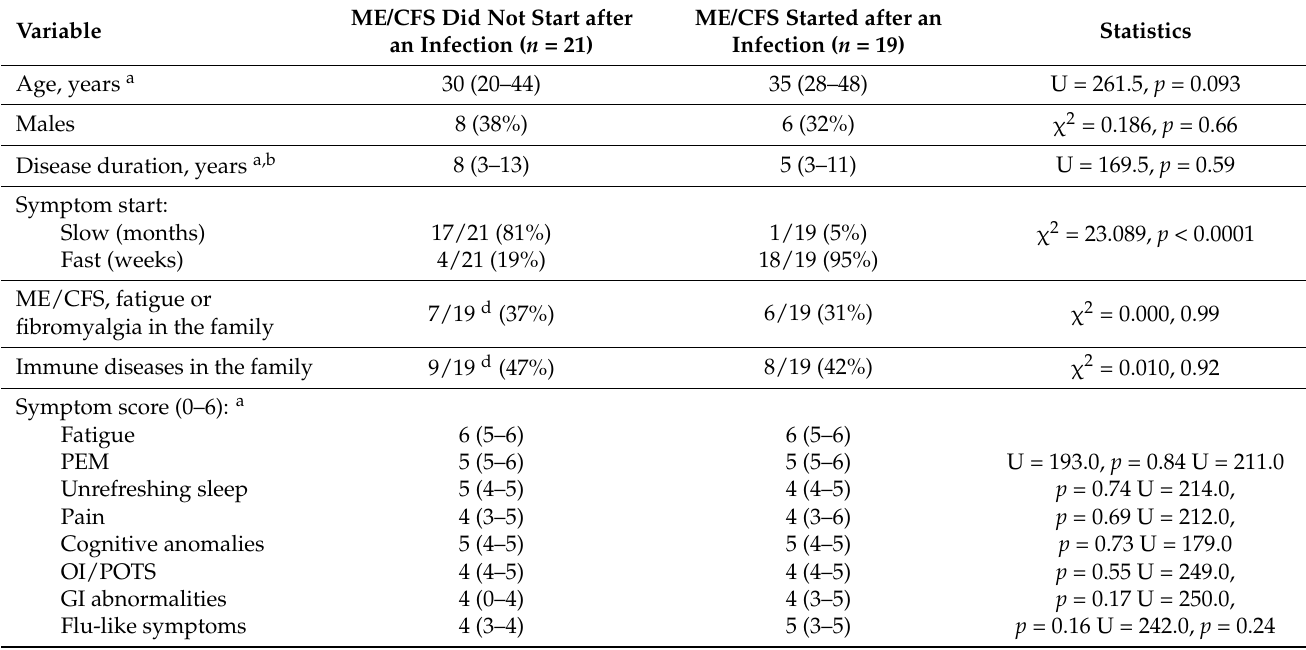
Table 4. Clinical characteristics of post-infectious ( n = 19) and non-post-infections ( n = 21) ME/CFS